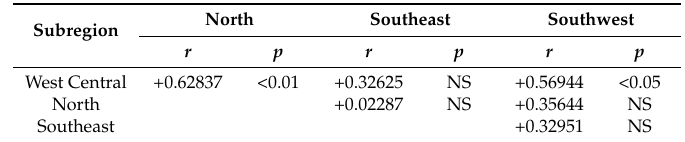
Table 7. Pairwise Spearman rank correlations to test for spatial synchrony in abundance in long-term monitoring units among subregions at Buena Vista Grassland during 1998–2015. N = 18 years for all correlations. NS = not significant ( p > 0.10).